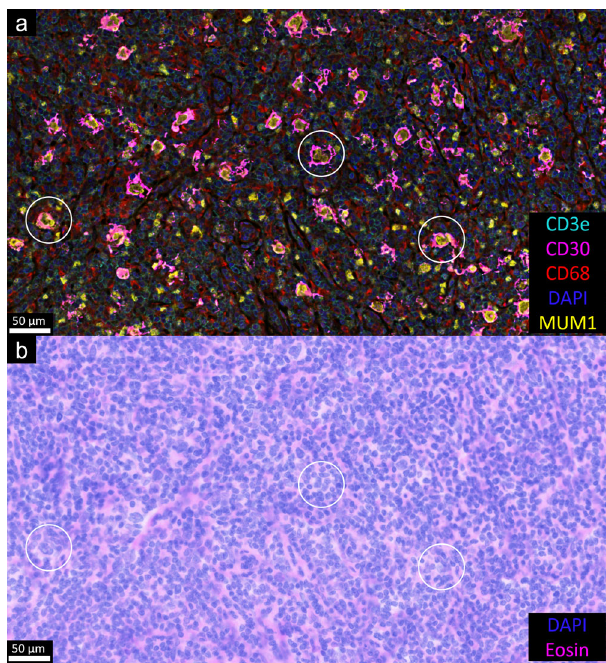
Fig. 3 Classic Hodgkin lymphoma stained using a combination of tyramide-barcodes and barcode-conjugated primary antibodies. a CD30 (1:50 dilution, mouse host, clone Ber-H2, Invitrogen) and MUM1 (1:100 dilution, mouse host, clone MUM1p, Agilent Dako Products) staining was performed using the tyramide-barcodes, which stains the cell membranes and nuclei of Hodgkin cells, respectively (scattered T cells also express MUM1). Other antigens were stained using commercially available barcode-conjugated primary antibodies (Akoya Biosciences, 1:200 dilutions except for CD3e, which was 1:100 dilution). DAPI = blue, CD30 = magenta, MUM1 = yellow, CD68 = red, CD3e = cyan. Staining for CD4, CD8, CD11c, CD20, CD45RO, CD107a, and Ki67 is shown in Fig. 4. b Virtual H&E staining was generated using DAPI and eosin fl uorescence images collected after the regular CODEX imaging 24 . Circles help to identify Hodgkin/Reed- Sternberg cells seen in the fl uorescence image and corresponding virtual H&E